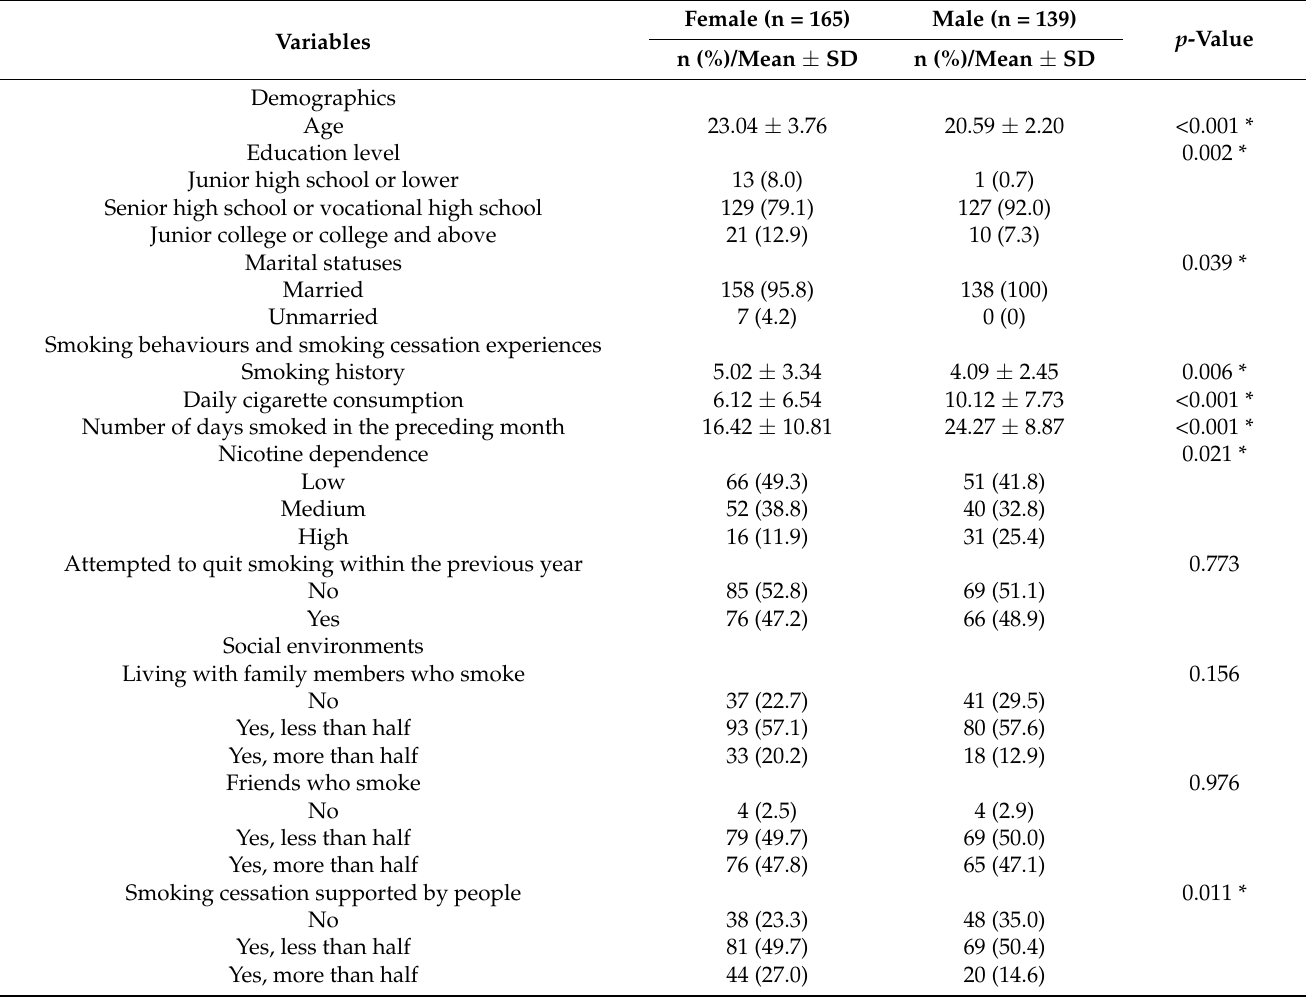
Table 1. Demographic characteristics, smoking behaviours, smoking cessation experiences, and social environments of study